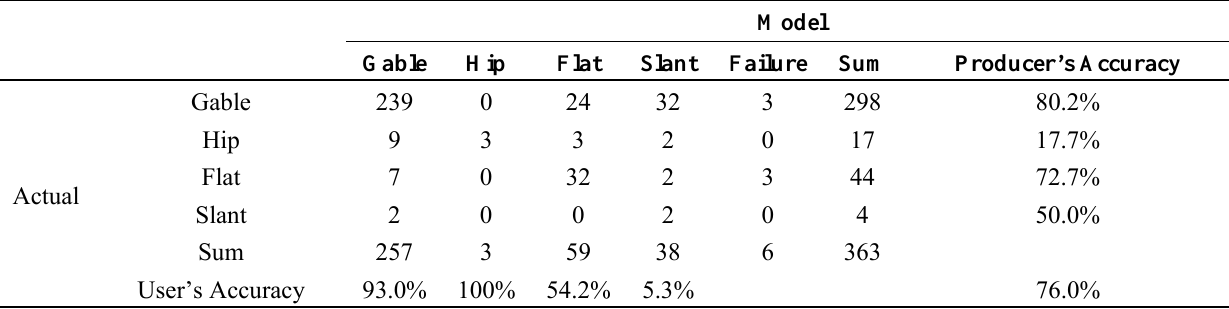
Table 3. Comparison between the buildings contained in the aerial image and those produced by the algorithm.